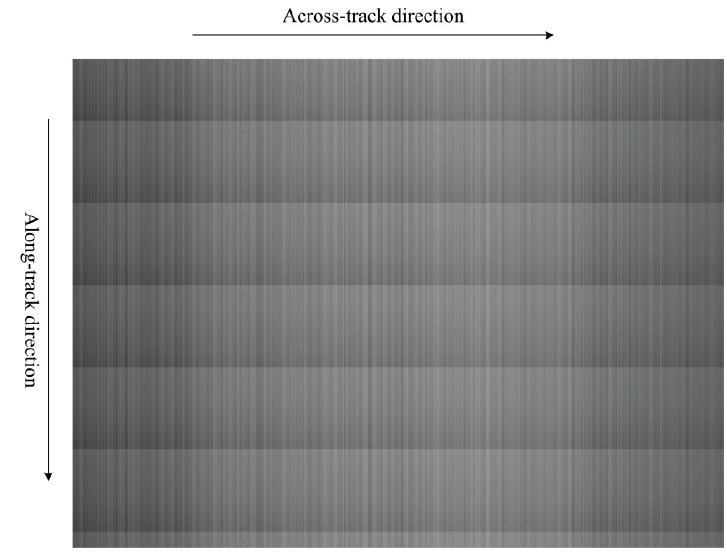
Figure 5. Original uniform-light